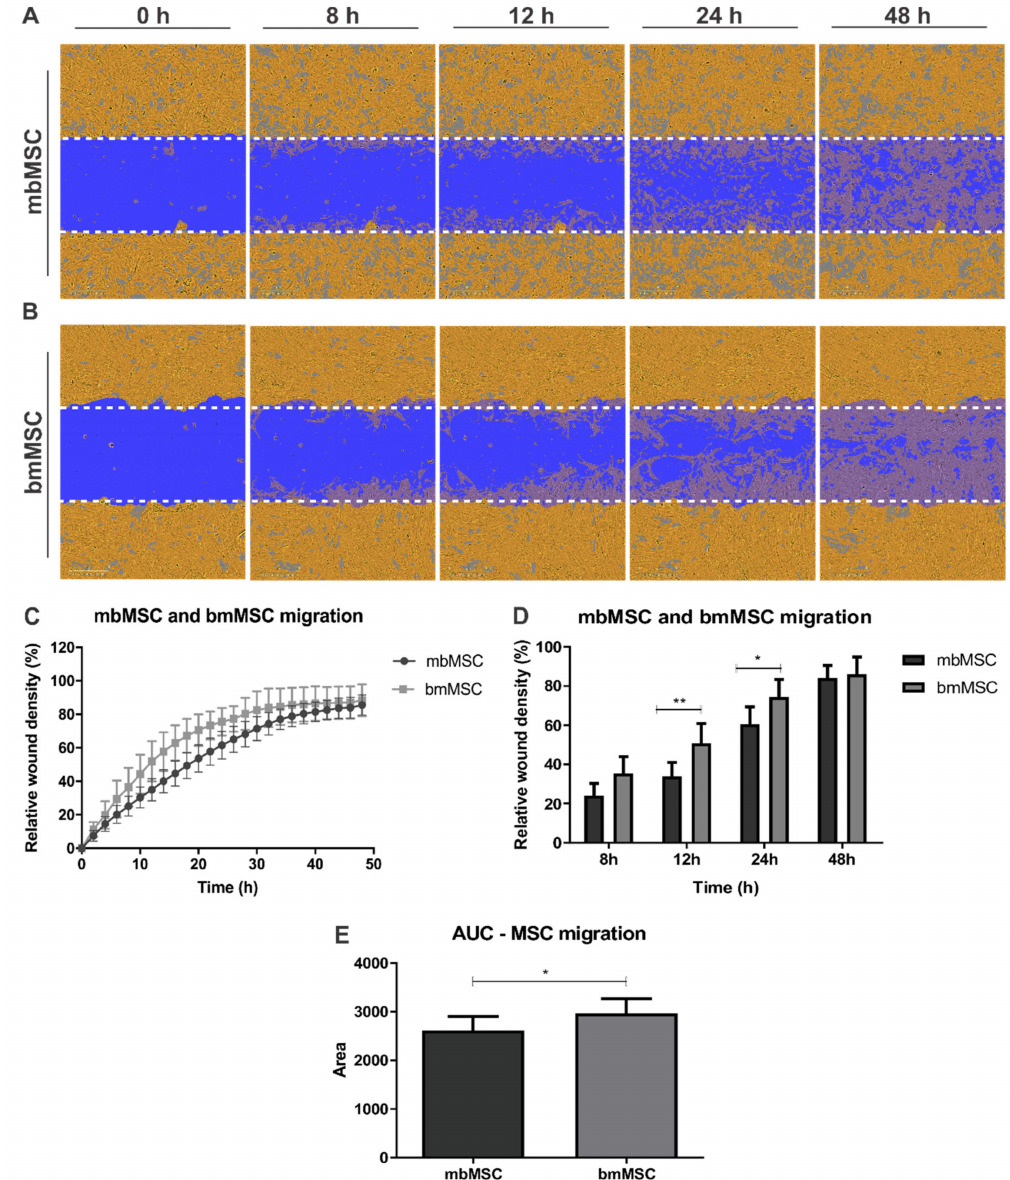
Figure 2. MSC migration capacity in vitro during scratch wound assay. ( A , B ) Representative images of ( A ) mbMSC and ( B ) bmMSC migration at the experimental times of 0, 8, 12, 24 and 48 h after scratch was performed. Cells around the wound are represented in orange, wound is represented in blue and migrated cells are represented in gray inside the blue region. Scale bars are 300 µ m. ( C ) Migration curves of mbMSC ( n = 7) and bmMSC ( n = 7) over the 48-h experimental protocol. ( D ) Relative cell densities quantification at di ff erent time points after scratch was performed (mbMSC versus bmMSC after 12 h, ** p < 0.01 and mbMSC versus bmMSC after 24 h, * p < 0.05). ( E ) Area under the curve quantification indicated that bmMSC migrated faster than mbMSC (* p <